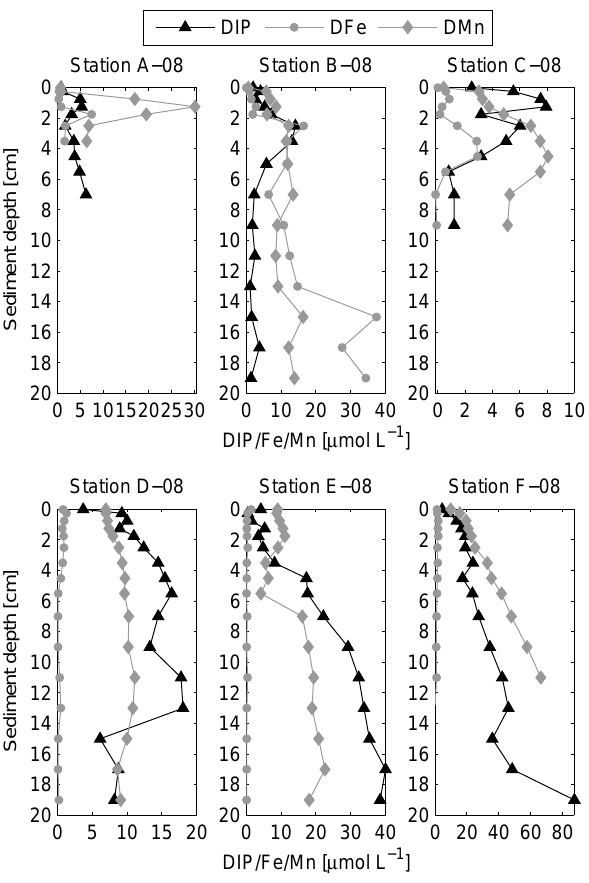
Fig. 4. Total dissolved Fe and Mn in pore water, together with pro- files of pore water DIP from 2008 (also shown in Fig. 3). Note the different scales on the x-axes.